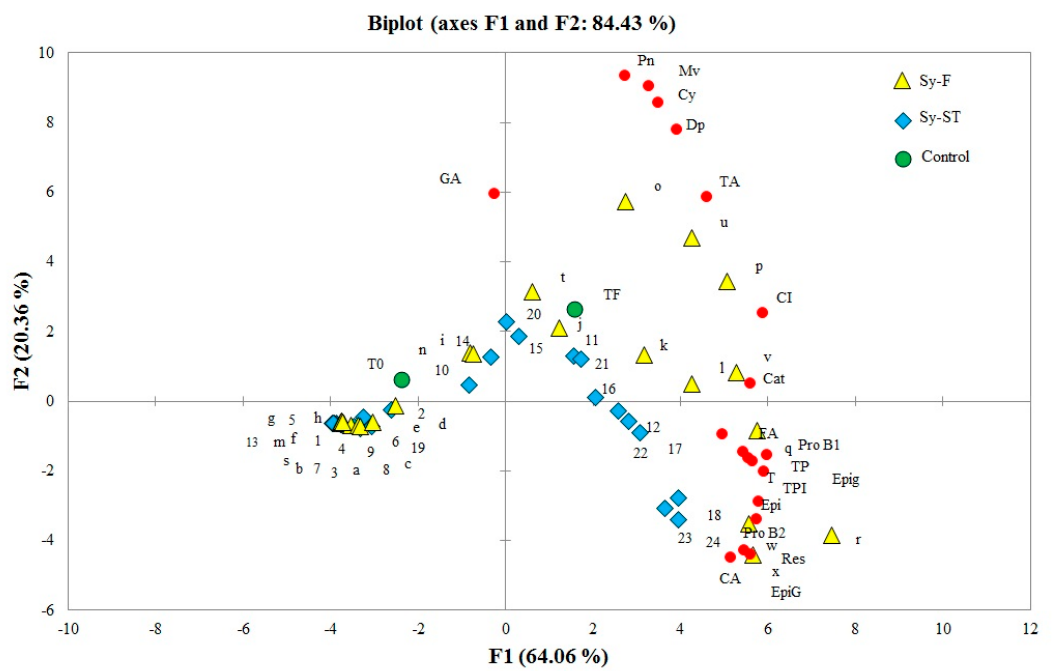
Figure 2. Biplot of the two first principal components obtained from the color and phenolic composition of the Sy-F (Syrah Florentine) and Sy-ST (Syrah Saint Thomas) musts compared to the Syrah Saint Thomas control (Sy-control): TA, total anthocyanin content; CI, color intensity; TPI, total polyphenol index; TP, total polyphenols; T, tannins; Dp, delphinidin-3-O-glucoside; Cy, cyanidin-3-